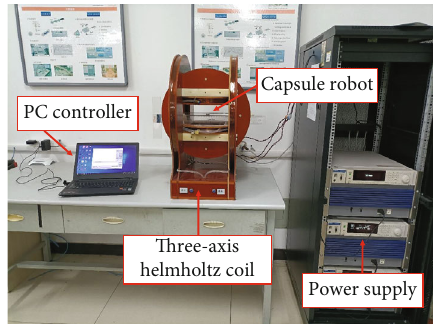
Figure 7: The electromagnetic actuation